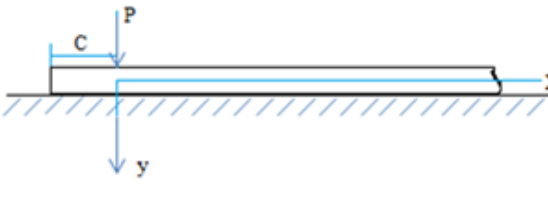
Fig. 7. The Beam on Elastic